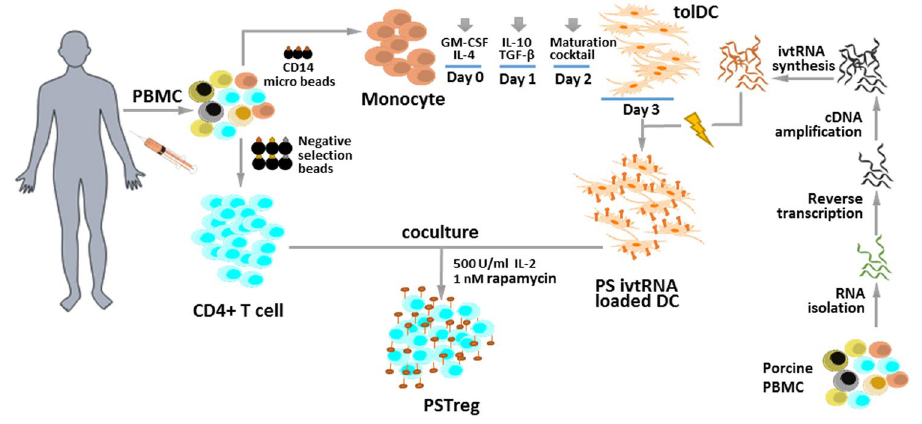
Figure 6. Flowchart of PSTreg